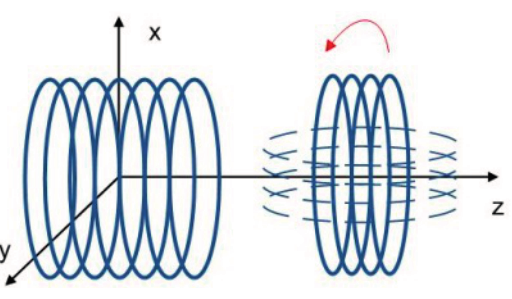
Figure 8. Multi and multi wound coils.